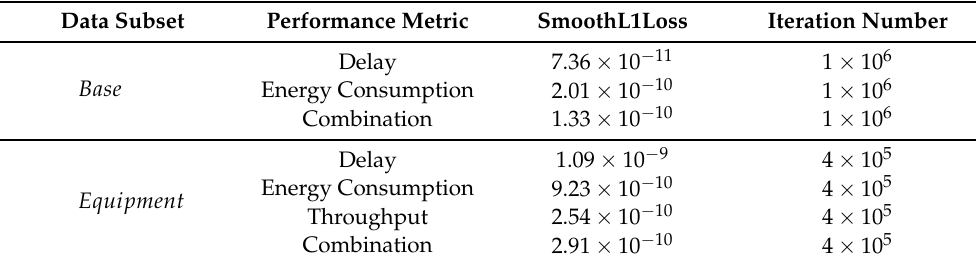
Table 5. Iteration number convergence of RL with Gradient Descent for single and combined performance metrics suggestion on Dataset Base and Dataset Equipment